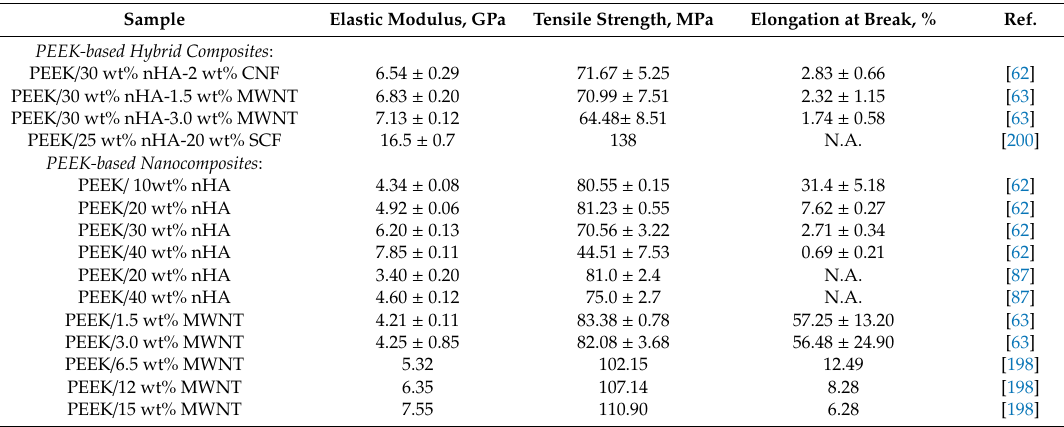
Table 2. Tensile properties of PEEK-based nanocomposites and hybrids. Sample Elastic Modulus, GPa